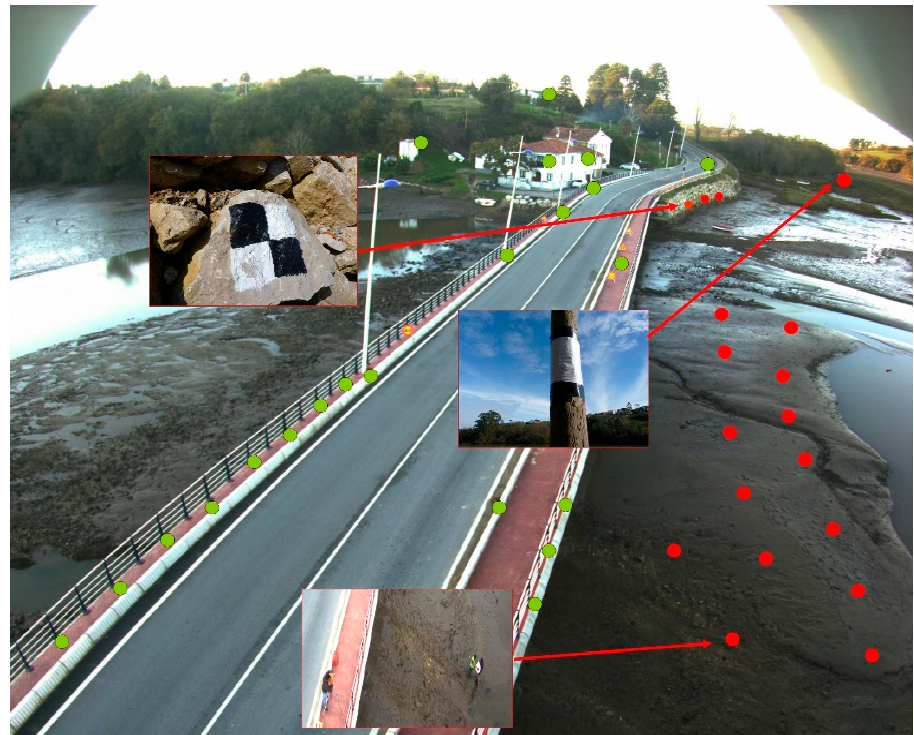
Figure 7. Points of selected field controls for Camera